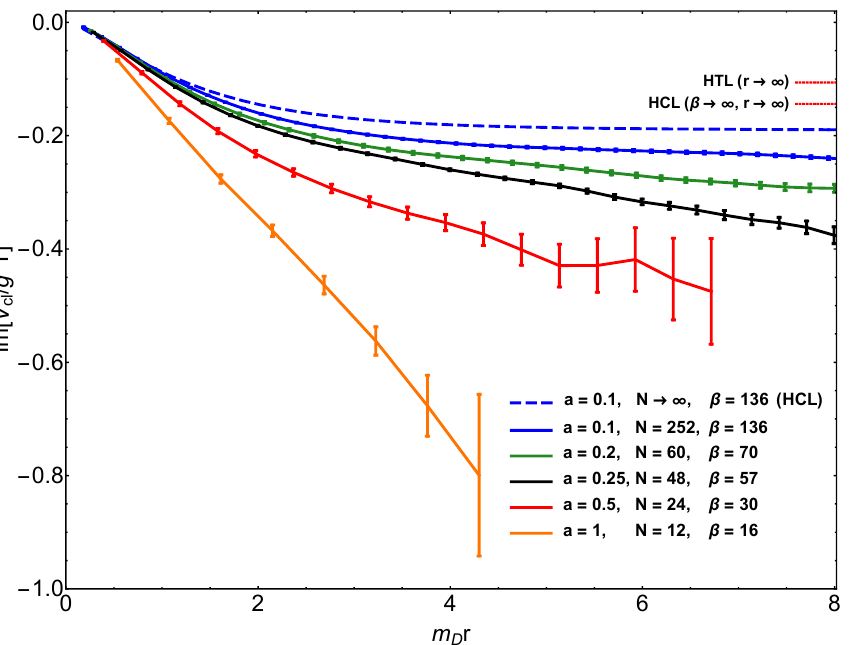
Figure 8 . Im[ V cl ( r )] /g 2 T for different lattice spacing from nonperturbative Wilson loops (solid lines) and from HCL perturbation theory for a = 0 . 1 (blue dashed line). The temperature val- ues (extracted from EE correlations) are slightly different for different values of a , and we write the corresponding β values instead. The r → ∞ limits of HCL for the continuum extrapolation β → ∞ (3.7) and of the dimensionally-regularized HTL perturbation theories (3.8) are indicated by short dotted red lines on the right axis for comparison. The distance in the horizontal axis is scaled using the HCL Debye mass (2.15) for m D ( a )